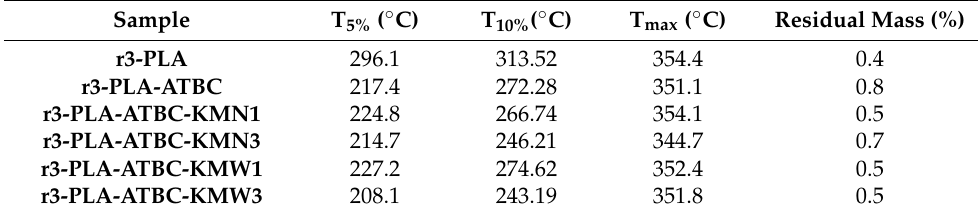
Table 3. TGA thermal properties of 3r-PLA-ATBC-based